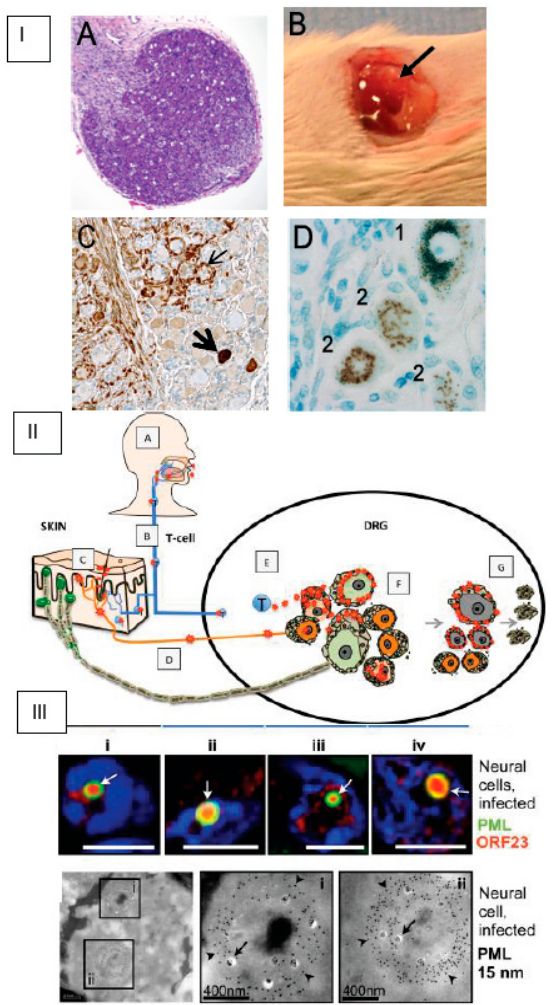
Figure 2. Varicella-zoster virus (VZV) infection of SCID-hu dorsal root ganglia (DRG) xenografts. Panel I. ( A ) Tissue section of fetal gestational DRG (18 gestational weeks) prior to implantation, stained with hematoxylin and eosin. ( B ) Appearance of DRG xenograft at four weeks post-transplant (arrow). ( C ) VZV-antigen immunohistochemistry in a tissue section of VZV-infected DRG during acute infection (brown signal indicates VZV protein in neurons (thick arrow) and satellite cells (thin arrow)). ( D ) Tissue section from a human cadaver DRG after VZV-antigen immunostaining, where numbers denote two di ff erent staining artifacts that occur when staining cadaver DRG tissue sections: 1, lipofuscin reactivity, which appears green upon counterstaining with azure blue; and 2, reactivity of blood group A1-associated antigens. Panel II. Primary VZV infection in respiratory epithelial cells ( A ) enables T-cell-mediated spread ( B ) to skin ( C ), followed by retrograde axonal transport to DRG neurons ( D ) or direct T-cell-mediated spread to DRG ( E ), which facilitates satellite glial cell (SGC) infection. VZV infects both nociceptive (small, orange) and mechanoreceptive (large, green) neuron cell bodies, but replication is severely restricted in mechanoreceptive neurons. If neuronal replication is uncontrolled, SGC infection facilitates spread to neighboring non-neuronal satellite cells ( F ) and associated neuronal cell bodies, amplifying VZV retrograde transport to skin. SGC infection also contributes to neuronal cell loss, resulting in satellite cell microproliferations (nodules of Nageotte; G ). Panel III. Upper: Neural cells have large ring-like promyelocytic leukemia (PML) cages (green, white arrows), where ORF23 capsid protein localizes (red). Lower: PML-specific immunogold-labeling of ultrathin cryosections shows that PML cages (PML, 15 nm; arrowheads) sequester VZV nucleocapsids (arrows) in infected neural cells. Areas in black squares ( i and ii ) are shown at higher magnification in right